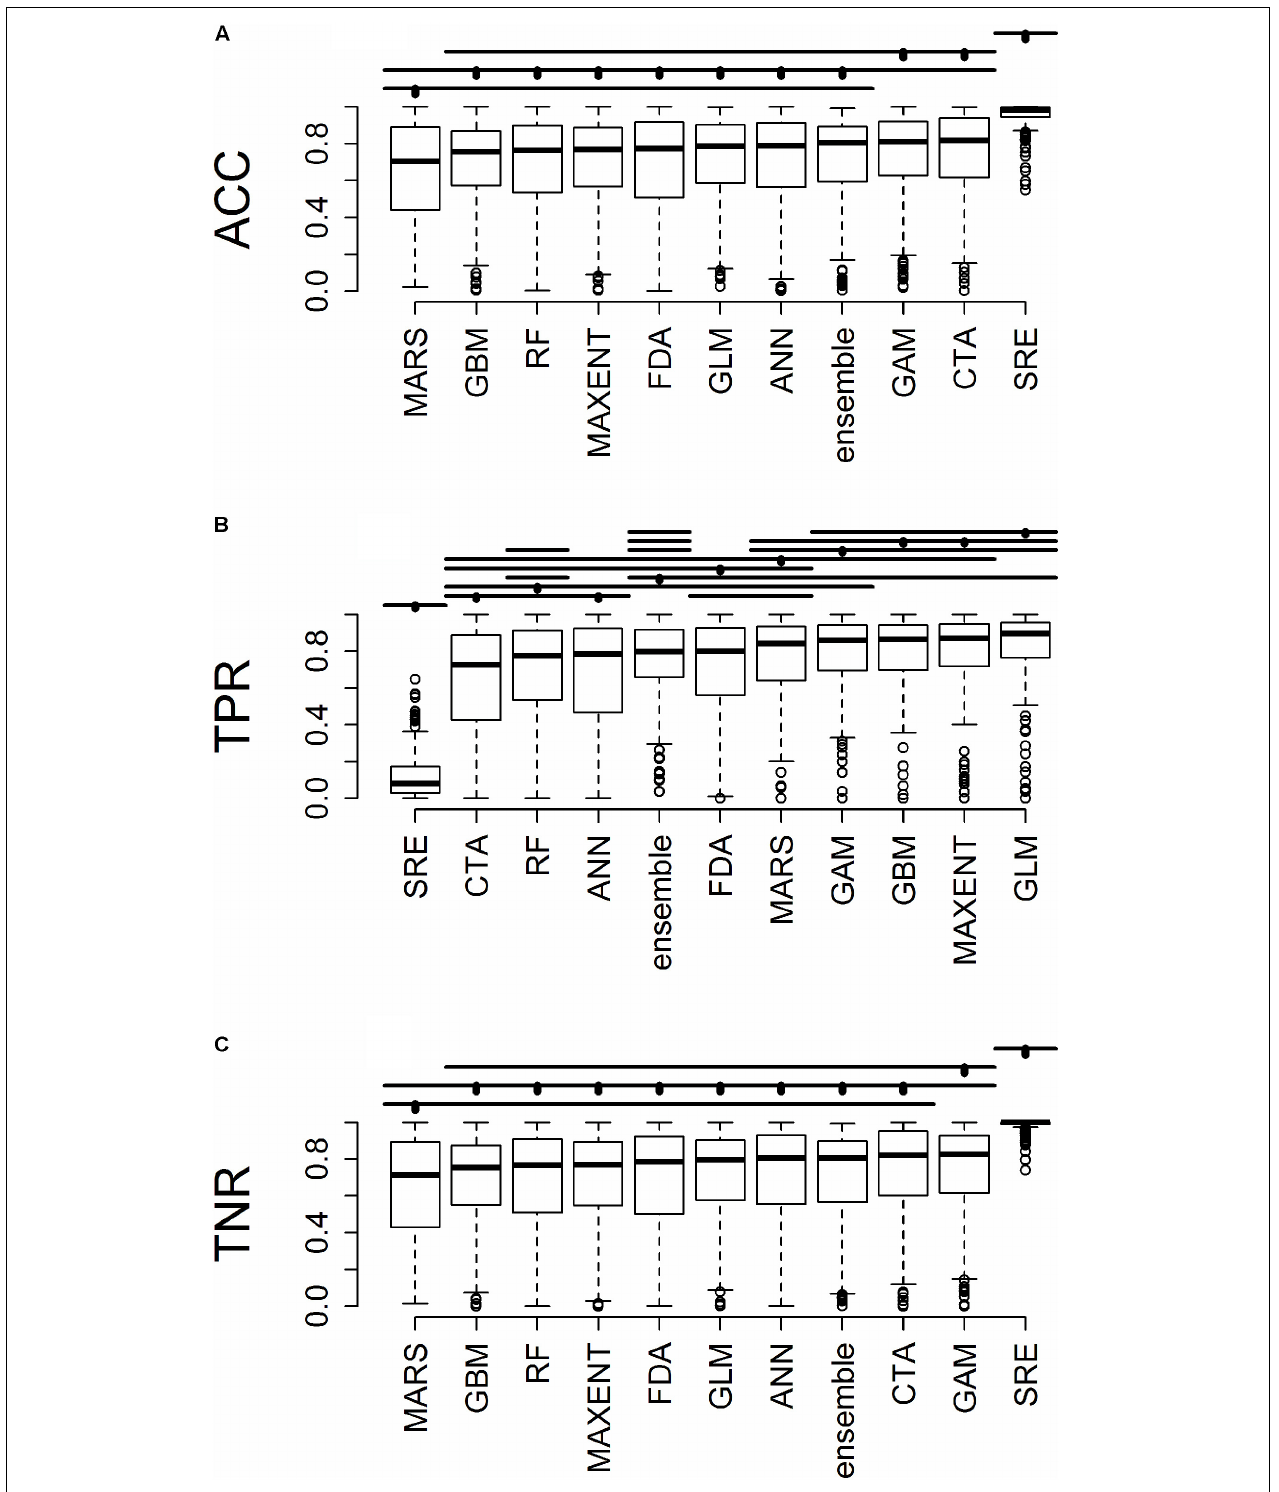
FIGURE 4 | For predictions into novel geographic regions, the distribution of (A) accuracy (ACC), (B) true positive rate (TPR), and (C) true negative rate (TNR). Horizontal bars above the boxplots represent significant Tukey post hoc groups. Black dots within the Tukey group bars represent the reference algorithm – all algorithms beneath a given bar are not significantly different from the reference algorithm for that bar. Multiple black dots on a given bar indicate that the Tukey groups are identical for multiple algorithms.